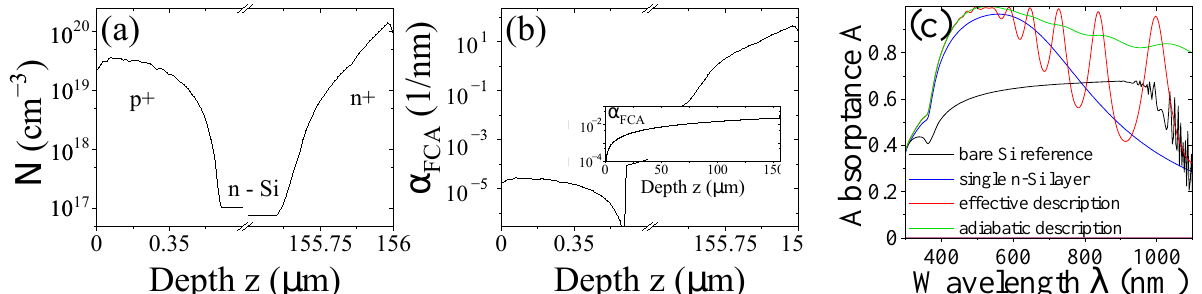
Figure 3. Si doping profiles as input for device modeling. ( a ) Electron doping as a function of the depth of the cell obtained from experimental measurements. ( b ) Calculated free carrier absorption across the cell. The inset shows the adiabatic connection in the n-doped center of width 150 µ m. ( c ) Comparing the achieved absorption using an intrinsic, an n-doped Si layer, an effective three-layer approach using average doping levels in front, back, and central region and an adiabatic approach using the full doping profile with effectively hundreds of layers in the scattering matrix